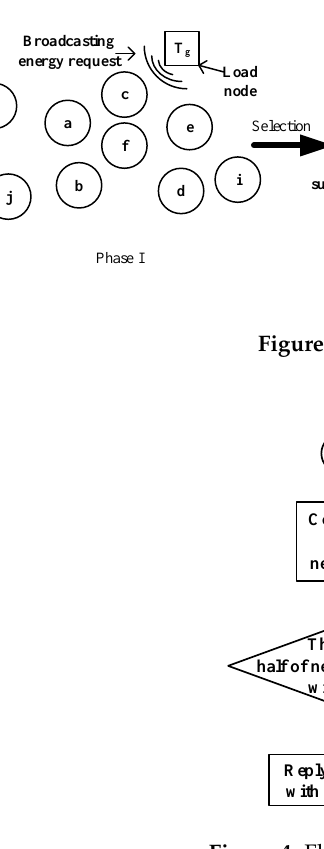
Figure 4. Flowchart of energy request